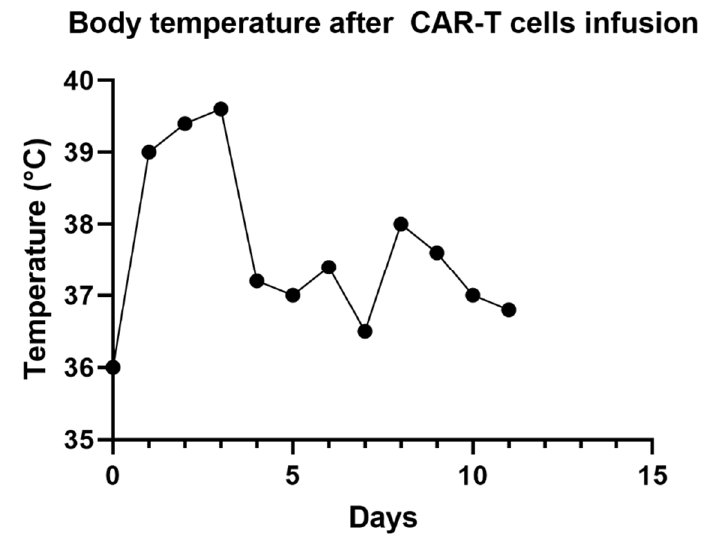
Figure 4. A timeline depicting changes in temperature during impatient management .